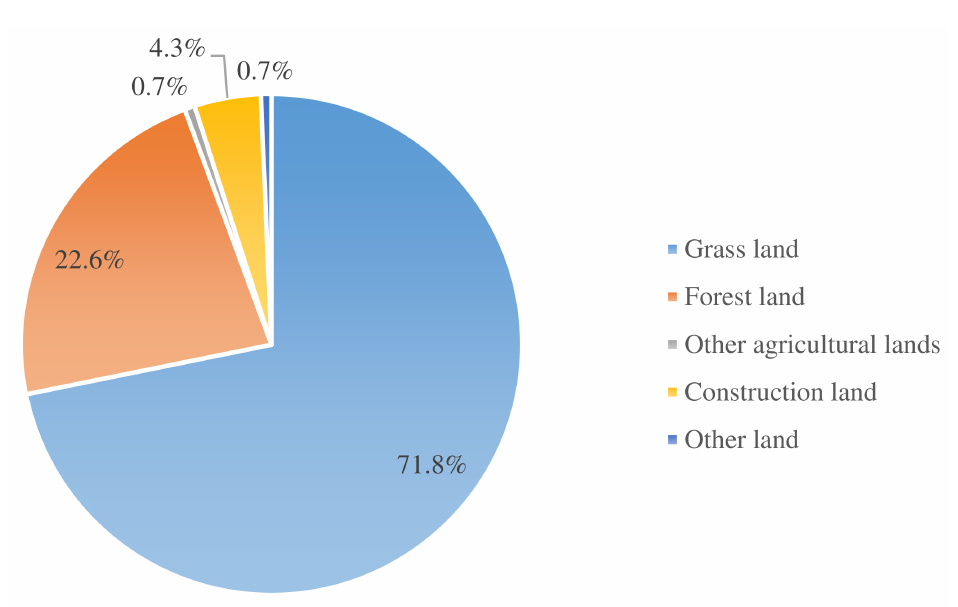
Figure 8. The sources of the new cultivated